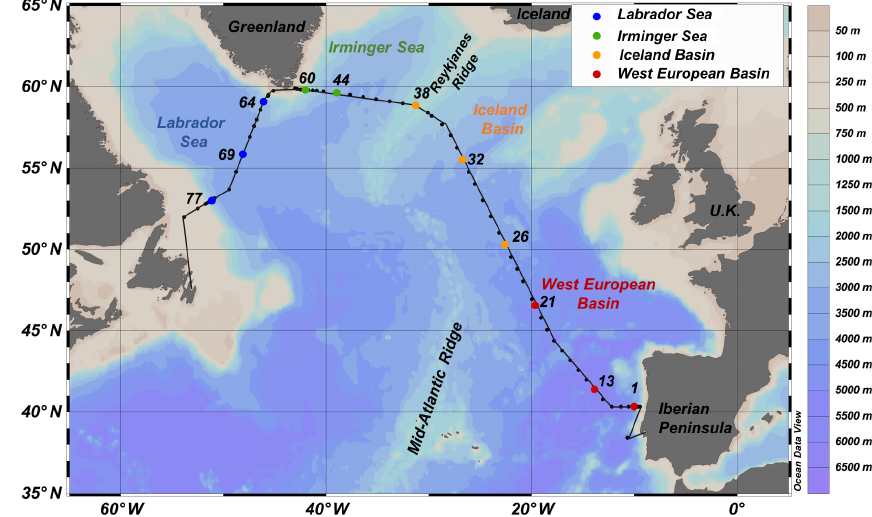
Figure 1. Map showing GEOVIDE cruise track (black line) and station locations (black dots). Colour bars indicate water depth. Sampling locations for water-column 231 Pa and 230 Th in this study are shown by coloured dots, with colours representing the oceanic regions they are located